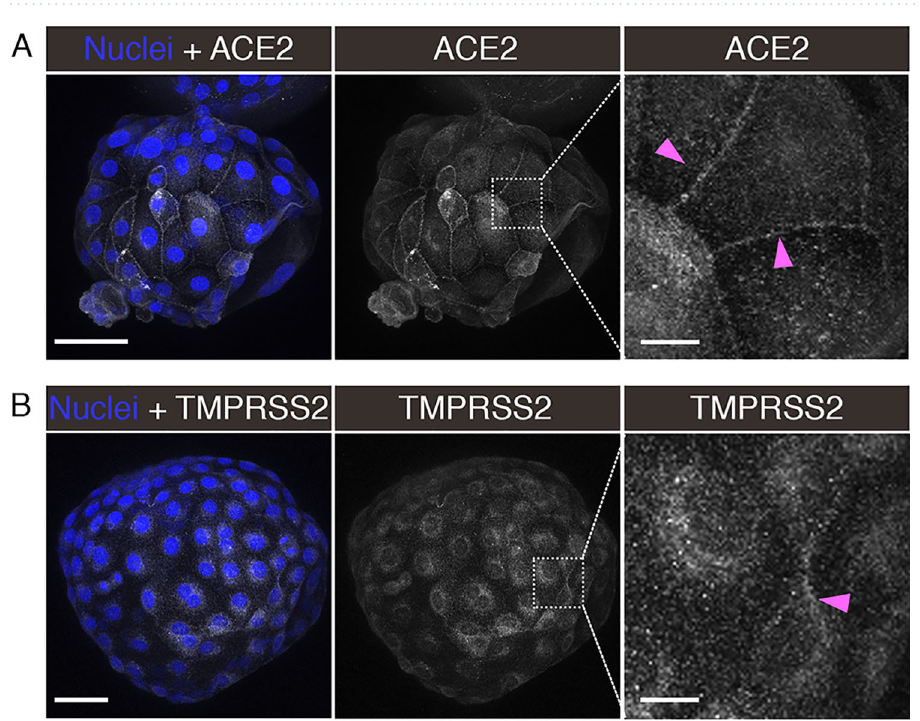
Figure 1. Expression of Genes Involved in SARS-CoV-2 Infection in Embryo Cells. Violin plots showing log10- normalized expression profiles obtained by RNA-seq performed on trophectoderm biopsies of blastocysts. Each data point represents one embryo (n = 24). Each trophectoderm biopsy consisted of 5–10 cells. ( A ) Canonical SARS-CoV-2 entry factors ACE2 and TMPRSS2 . ( B ) Proposed alternative/ancillary mediators of SARS-CoV-2 entry, replication, traffic, and assembly.